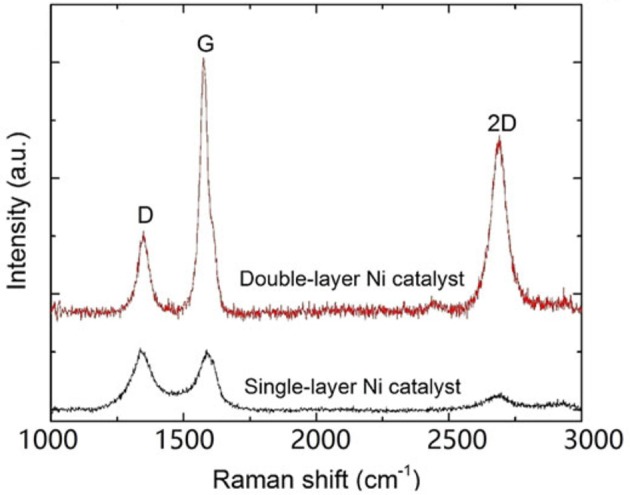
Raman spectra of samples with single- and bilayer catalysts deposited at 3 mJ [Reproduced from Dong et al. (2017) with permission of Springer].